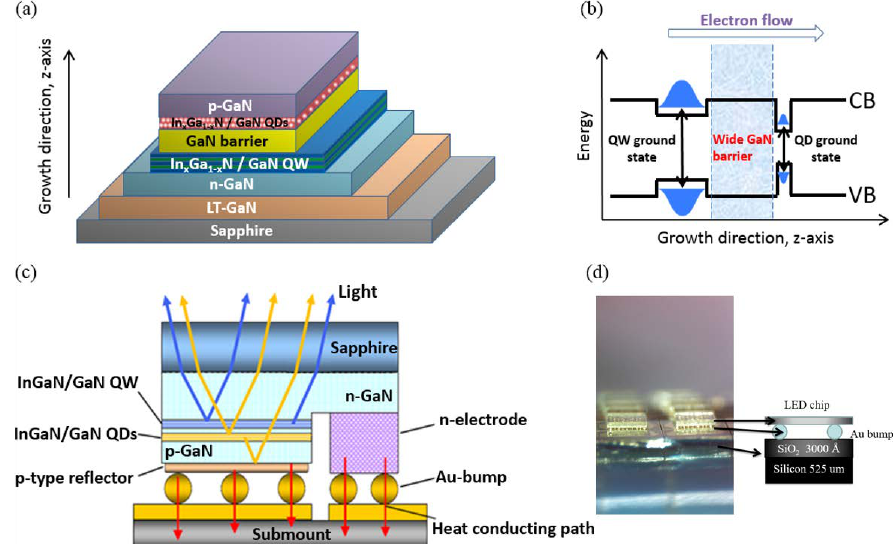
Figure 1. ( a ) The schematic diagram of the white light emitting diode (LED) samples based on indium gallium nitride (InGaN) QDs and QWs; ( b ) A thick tunneling block layer was inserted between QD and QW layers; ( c ) The schematic diagram of the QD/QW white LEDs with flip-chip mounting; ( d ) The picture of fabricated QD/QW white LED after the flip chip (FC)